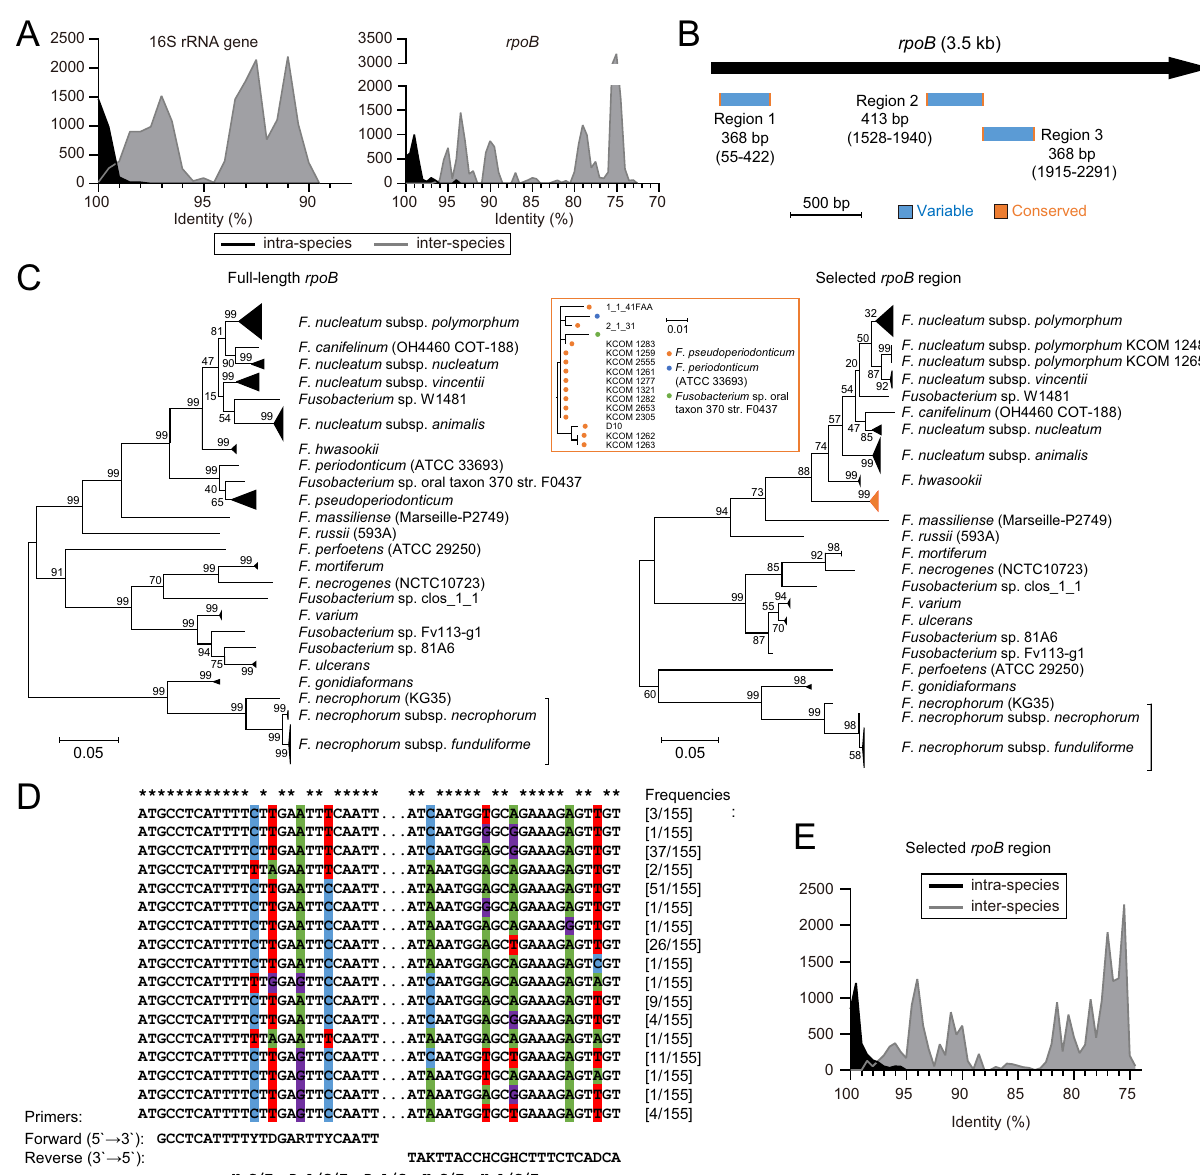
Fig. 2 Development of a rpoB -based approach for Fusobacterium differentiation at the species level. A Distributions of pairwise intra- and inter-species identities of the 16S rRNA ( n = 2610 and n = 17,696, respectively) and rpoB genes ( n = 3068 and n = 20,802, respectively) from the genomes. B Locations of three candidate regions compatible with amplicon sequencing found in rpoB . The reference length and coordinates (in parentheses) in the rpoB gene of F. nucleatum subsp. nucleatum ATCC 25586 are given. Region 1 was selected for further study. C Phylogenetic trees of full-length rpoB and their corresponding selected rpoB region. Strain names are given in parentheses for the species with only one sequenced genome available. Branches of the same species/ subspecies or those otherwise illustrated in the orange box (corresponding to the orange triangle) are compressed as applicable. There is an exception in the sub-tree of F. necrophorum subsp. funduliforme , which is illustrated in Fig. S3. Strain names are also provided for those that could not be compressed together. D Alignment of the non-redundant terminal conserved sequences of the selected rpoB region and universal primers designed based on these conserved regions. Asterisks denote consensus bases. Variations are denoted by nucleotide-speci fi c colour shades. E Distribution of pairwise intra- and inter-species identities of the selected rpoB region ( n = 3068 and n = 20,802, respectively). Complete gene sequences available in the sequenced genomes were used for analysis (144 16S rRNA gene and 155 rpoB sequences). F. naviforme genomes ( n = 2) were not included. The analysis considered the four F. nucleatum subspecies as separate species. Source Data are provided as a source data fi polymorphic regions of 300 – 500 bp bounded by >20 bp con- Fusobacterium species (Fig. 2C). The termini of the region were served sequences. Three candidate regions were identi fi ed ~25 bp in length and highly conserved among Fusobacterium (Fig. 2B), and only Region 1 was selected as it was found to be species, based on which a set of universal primers was designed speci fi c to Fusobacterium based on comparison against the NCBI (Fig. 2D). The primers yielded a single speci fi c band from nucleotide database. The selected region was ~370 bp in length different Fusobacterium isolates (Table S1) and human faecal and located close to the 5 ′ end of the gene. Notably, the samples (Fig. S4A). We also assessed whether the primers were phylogeny of this region retained the capacity of distinguishing speci fi c to Fusobacterium using in silico analysis against the NCBI